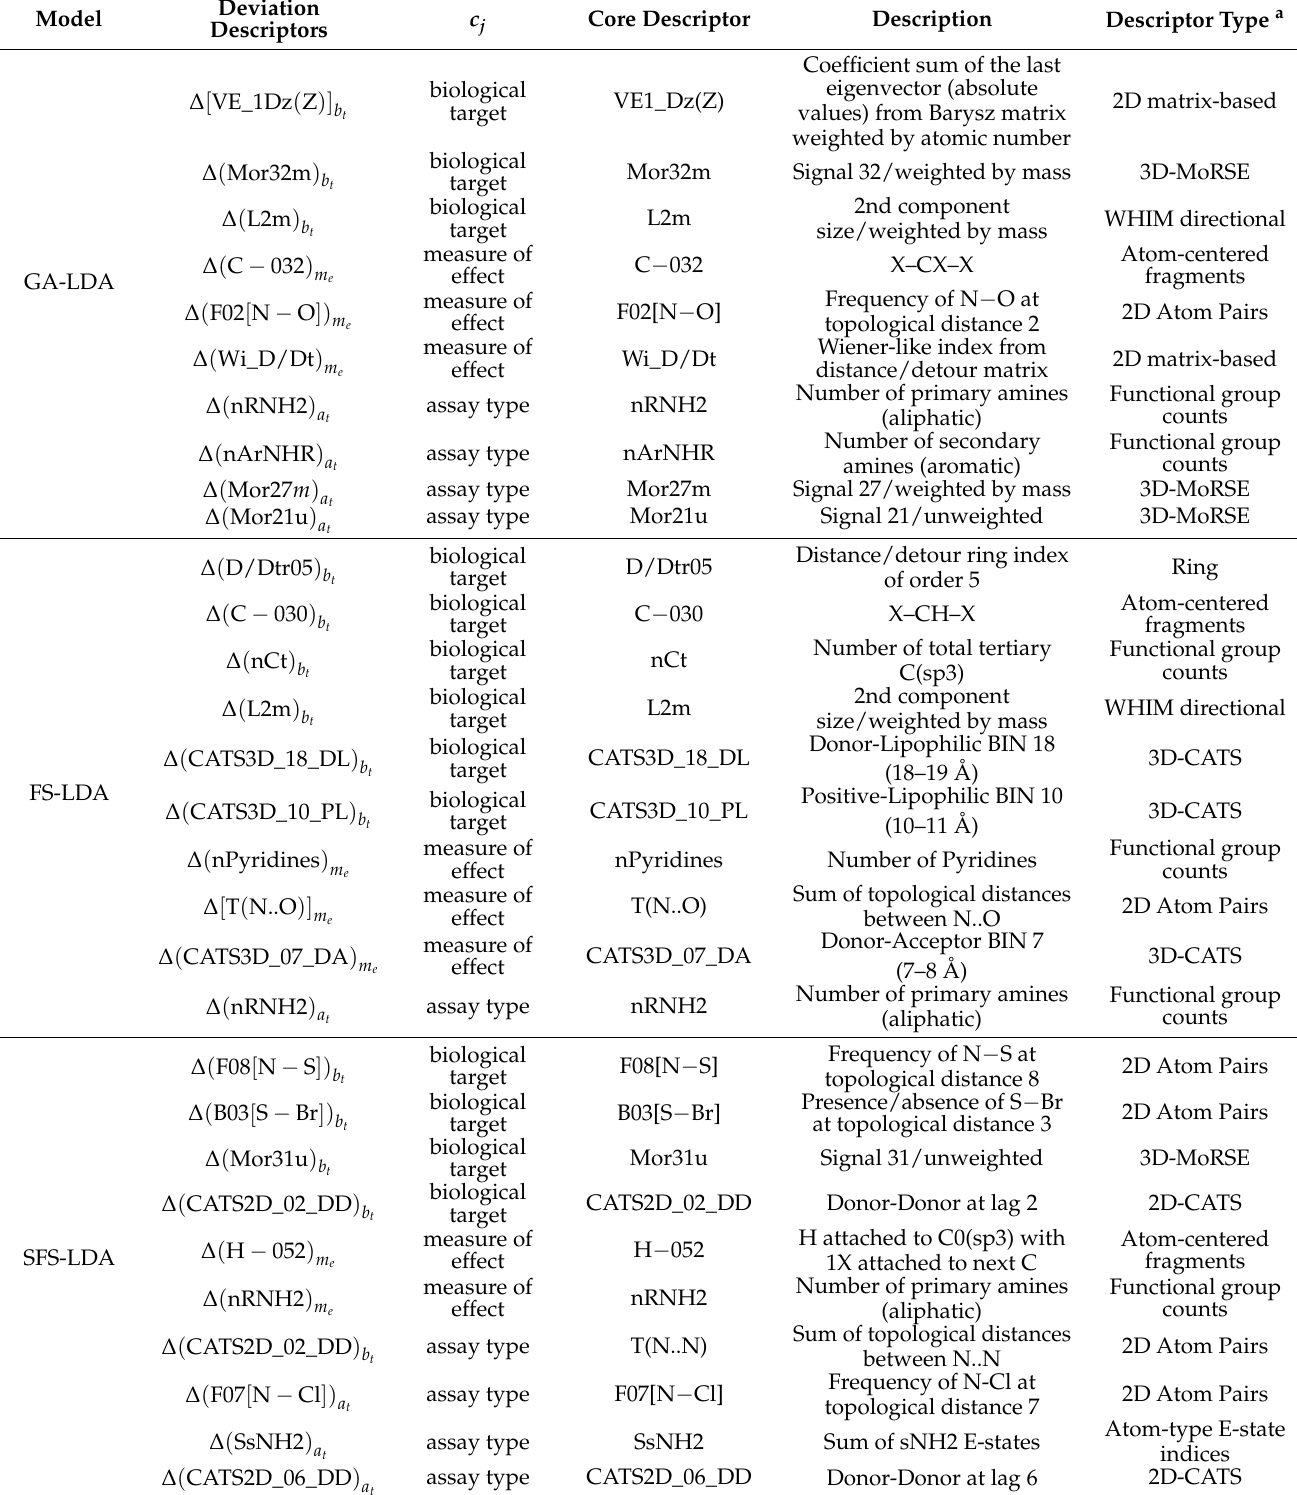
Table 4. Deviation descriptors of the mt-QSAR LDA models and their respective